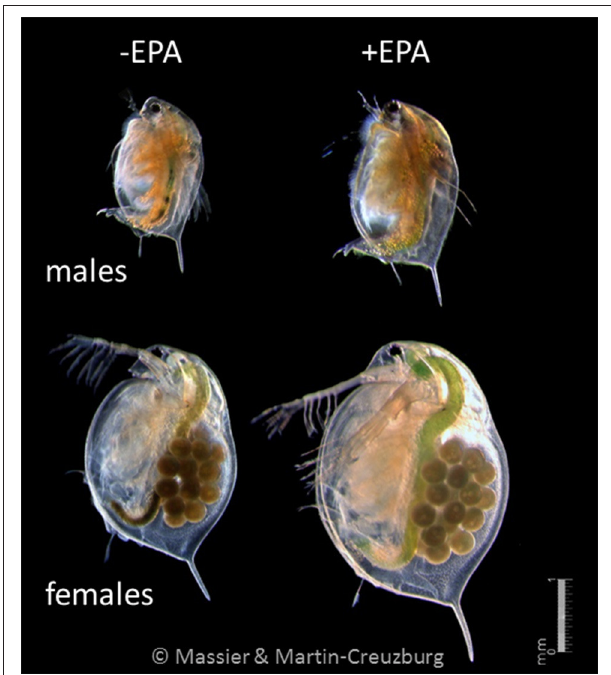
FIGURE 8 | Female and male D. magna reared on S. obliquus and S. obliquus supplemented with EPA. The photographs were taken at the end of the life history experiment when females deposited their third clutch eggs in their brood chambers (day 16.7 without EPA, day 13.6 with EPA). Both sexes benefited from dietary EPA supplementation but the effects of EPA enrichment were most pronounced regarding female